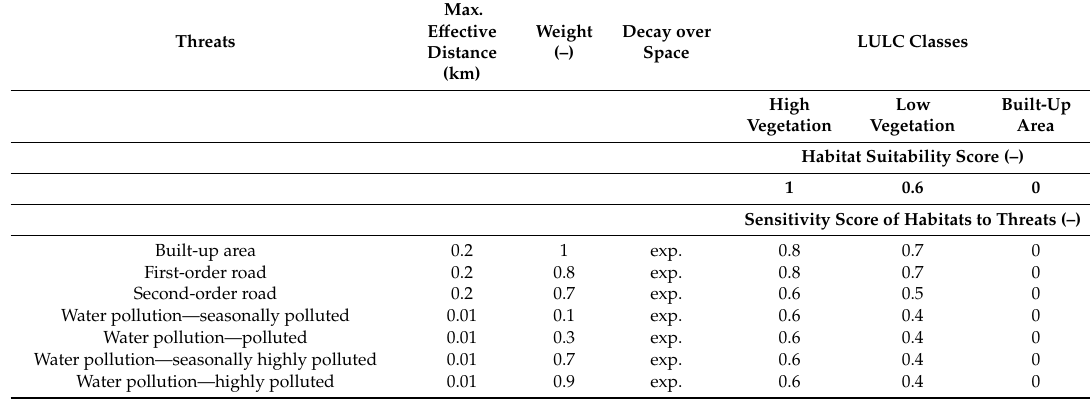
Table 2. Threat parameters, habitat suitability, and sensitivity used in this